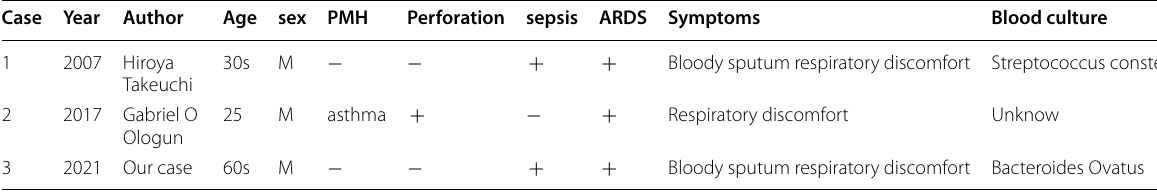
Table 1 Cases of ARDS after surgery for acute appendicitis Case Year